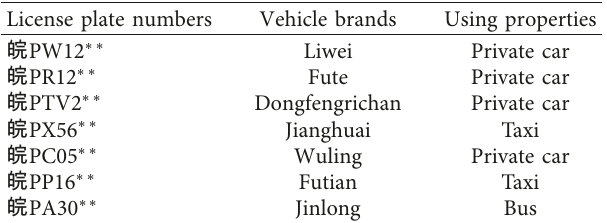
Table 2: Information on ride-hailing vehicles. Table 1: Information on urban vehicles.